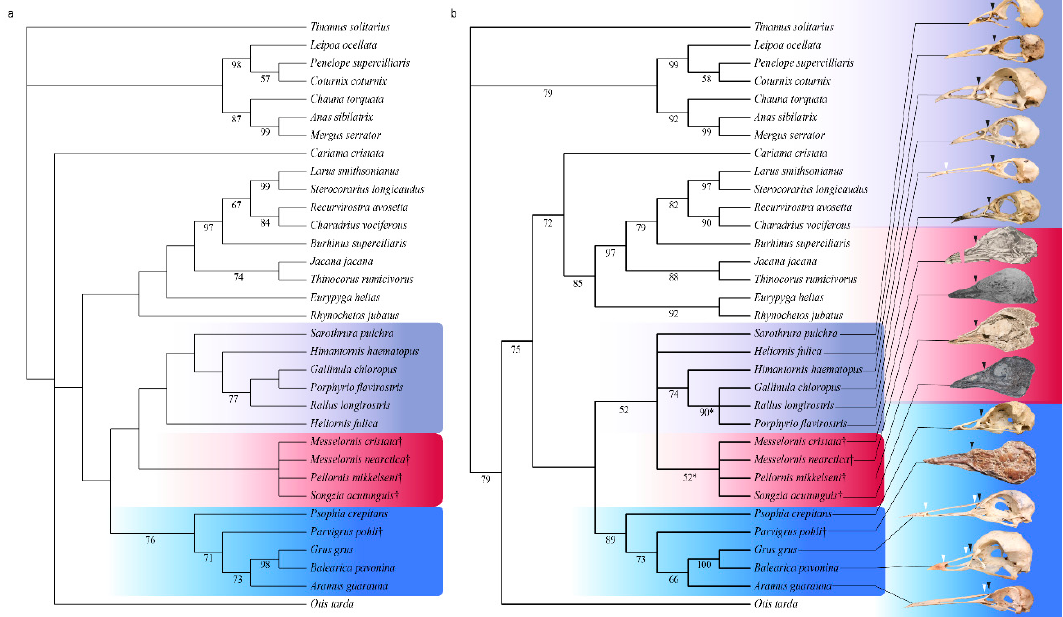
Figure 6. Strict consensus tree of 30 MPTs recovered from unconstrained heuristic parsimony analysis ( a , steps = 325, CI = 0.357, RI = 0.701, RC = 0.250, HI = 0.643) and strict consensus tree of 48 MPTs recovered using the Prum et al. [3] tree as a molecular backbone constraint ( b , steps = 333, CI = 0.348, RI = 0.690, RC = 0.240, HI = 0.652). Crown Ralloidea are highlighted in violet, crown Gruoidea are highlighted in blue, and included extinct ralloid taxa are highlighted in crimson (Messelornithidae and Songzia acutunguis ). All extinct taxa are denoted with daggers. Bootstrap support values greater than 50% are denoted below branches. Black arrows in extant skulls denote the craniofacial hinge, with white arrows representing additional bending axes along the dorsal bar following Zusi [59]. Black arrows in fossils represent the level of the craniofacial hinge as bending zones cannot be determined in fossils. Photographs of skulls from top to bottom: Sarothrura pulchra USNM 291778, Heliornis fulica USNM 19159, Himantornis haematopus USNM 318591, Gallinula chloropus USNM 603455, Rallus longirostris USNM 501940, Porphyrio flavirostris USNM 623070, Messelornis cristata (composite photo made from Tafel III:8 and Tafel IV:10) [30], Messelornis nearctica [24] Pellornis mikkelseni